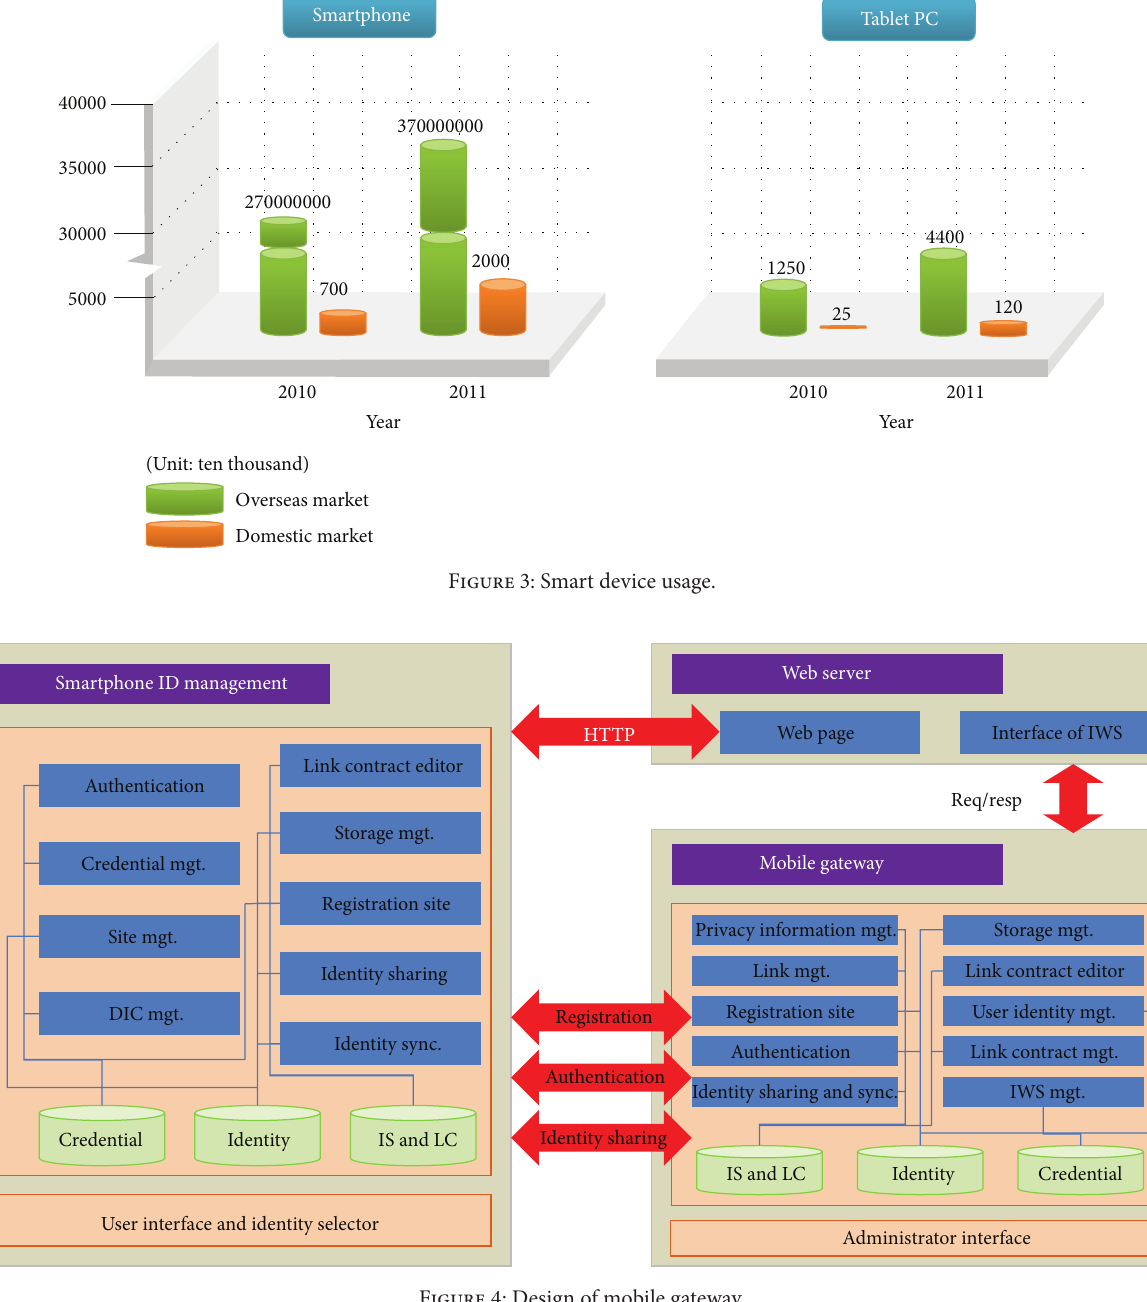
Figure 4: Design of mobile